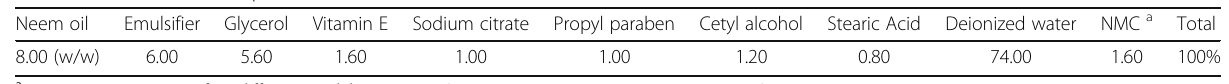
Table 2 Neem cream recipe Neem